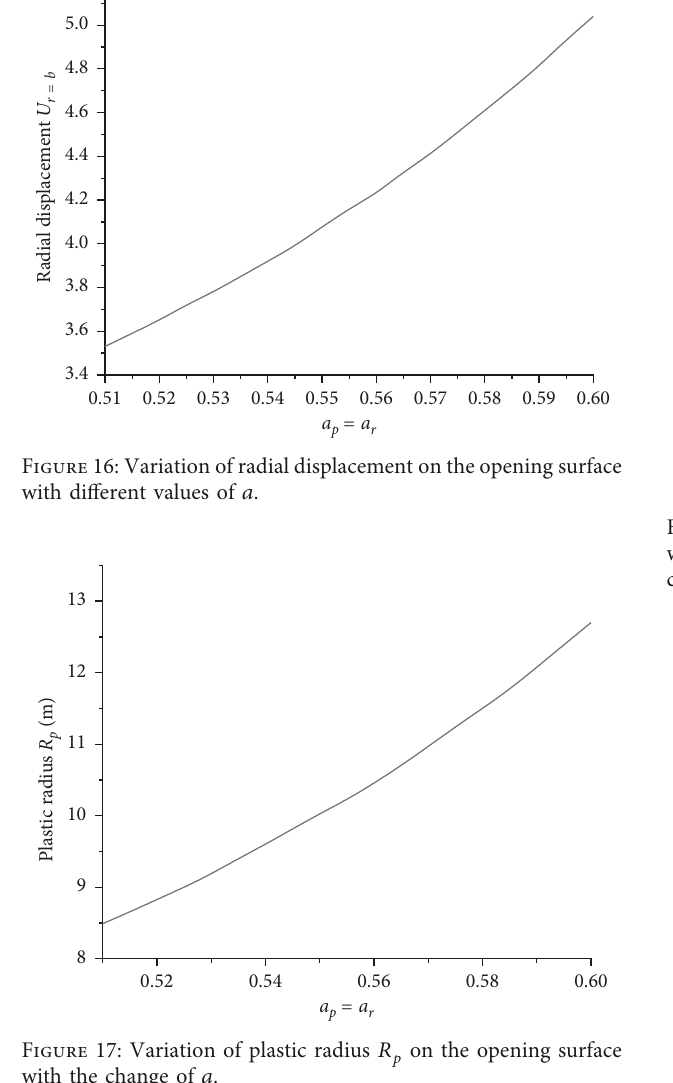
p on the opening surface